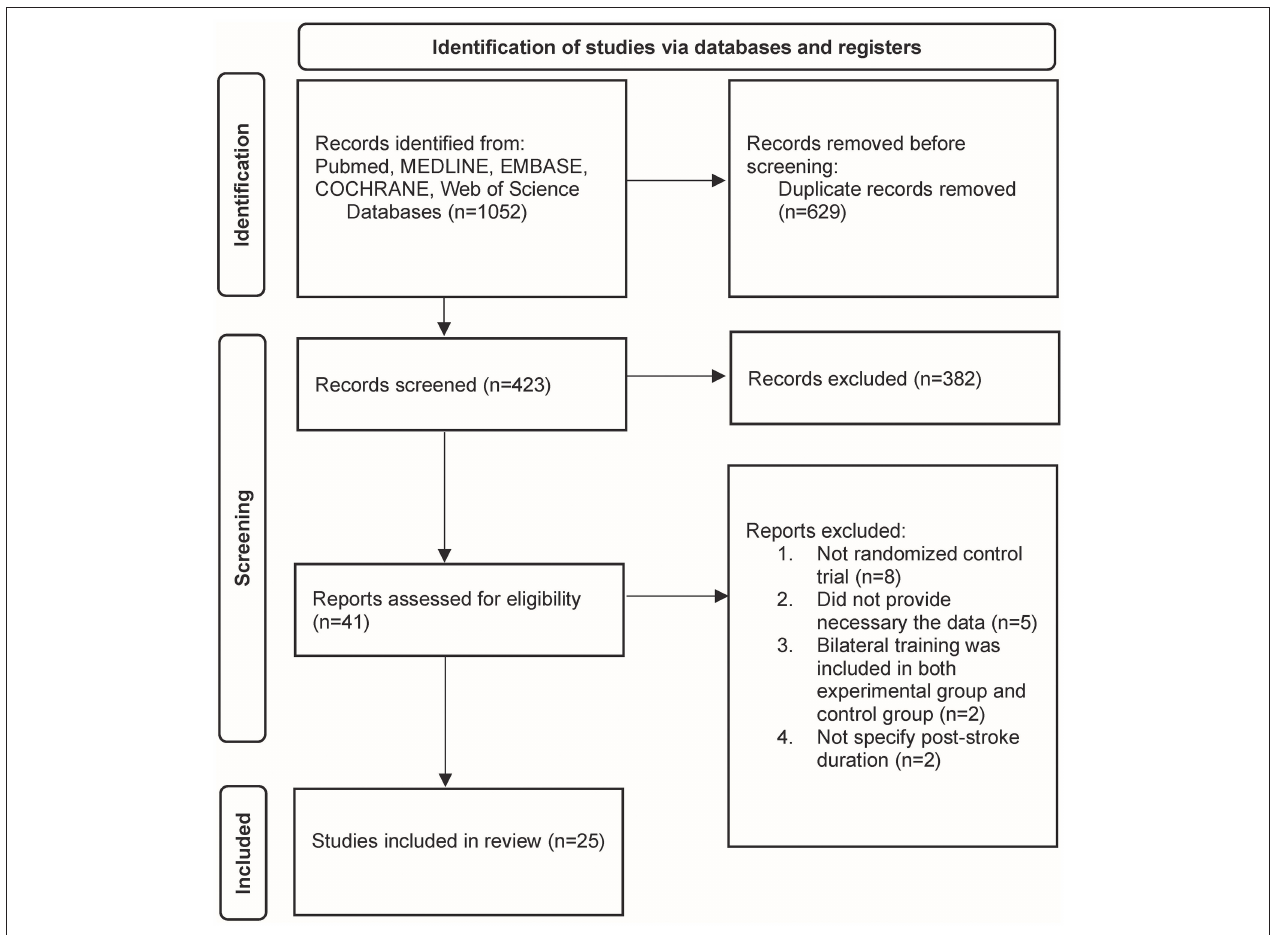
FIGURE 2 | The Preferred Reporting Items for Systematic Reviews and Meta-Analyses (PRISMA) flowchart of study